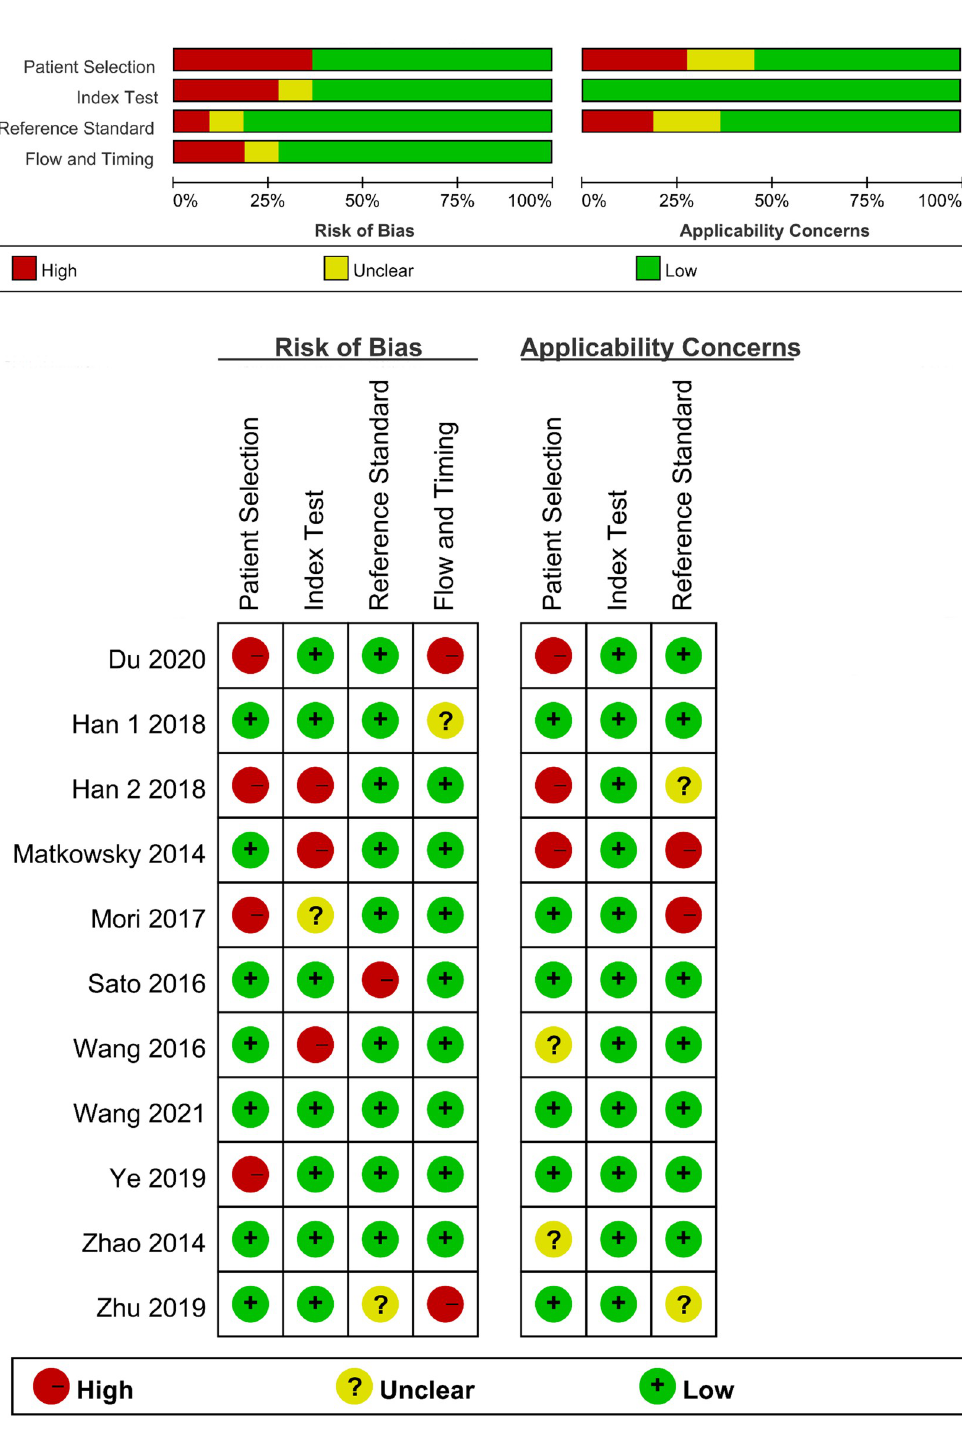
PLOS ONE | https://doi.org/10.1371/journal.pone.0279591 December30,